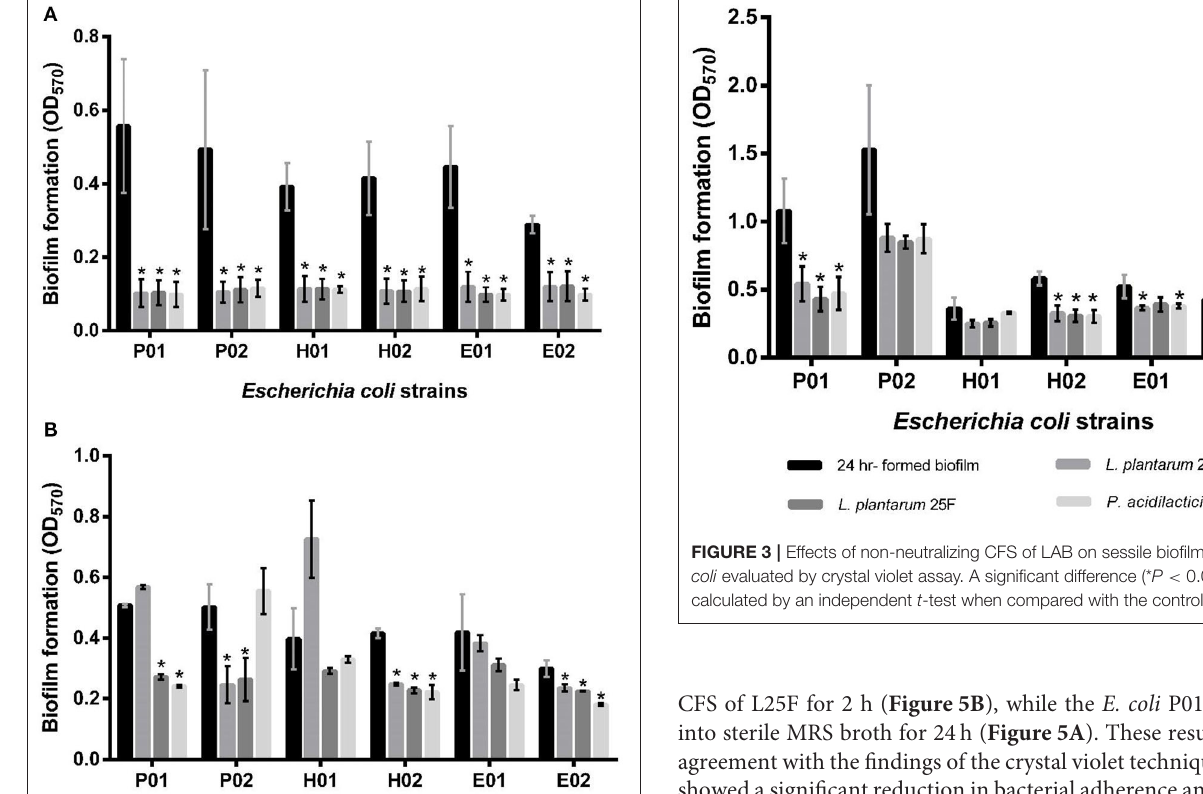
The percentage inhibition of biofilm was 60.10%, in the case of L.